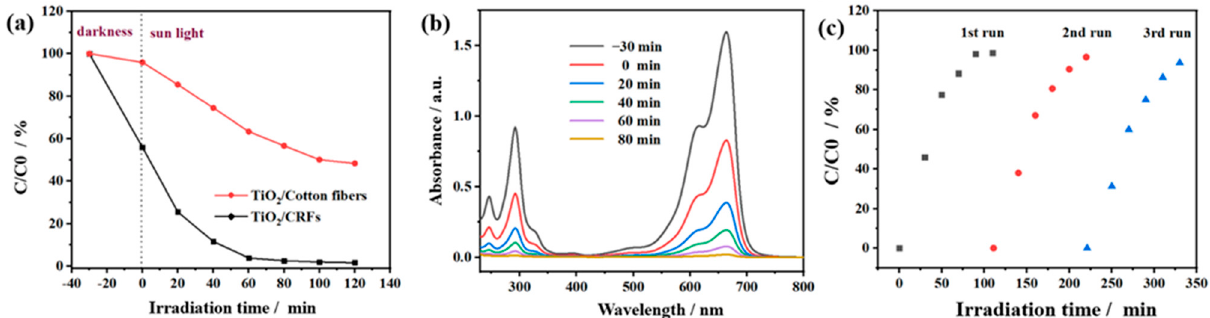
Figure 9. ( a ) Photocatalytic degradation activity of TiO 2 /CRFs and TiO 2 /Cotton fibers under the condition of sunlight; ( b ) Sunlight absorption curve of photodegradation of MB upon TiO 2 /CRFs; ( c ) Cycle experiments of TiO 2 /CRFs used for photocatalytic degradation of MB.